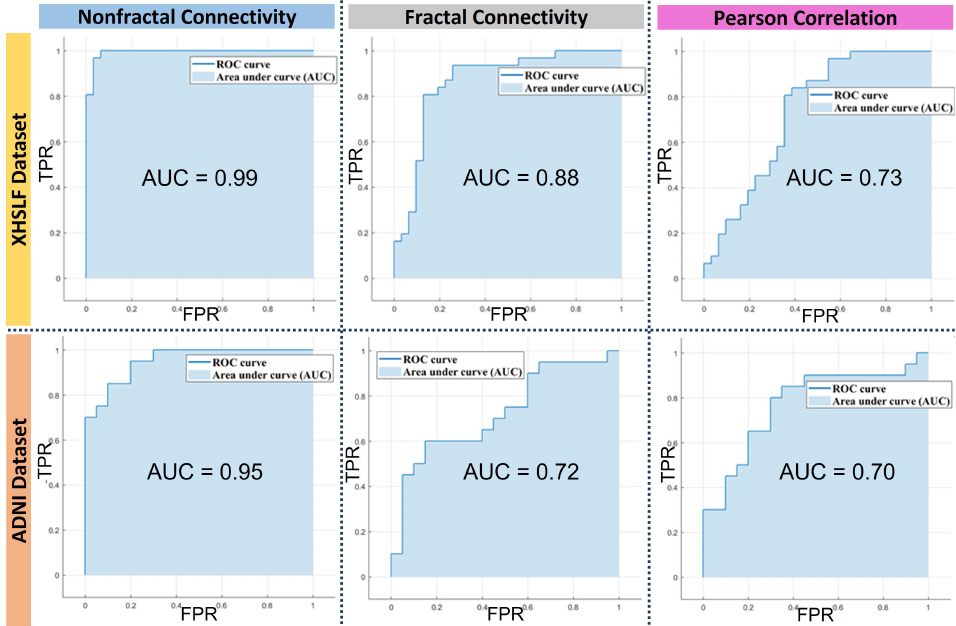
Figure 7. ROC curve and AUC for classification of AD vs. NC using functional connectivity of rs-fMRI as input feature vectors to SVM classifier for dataset XHSLF and